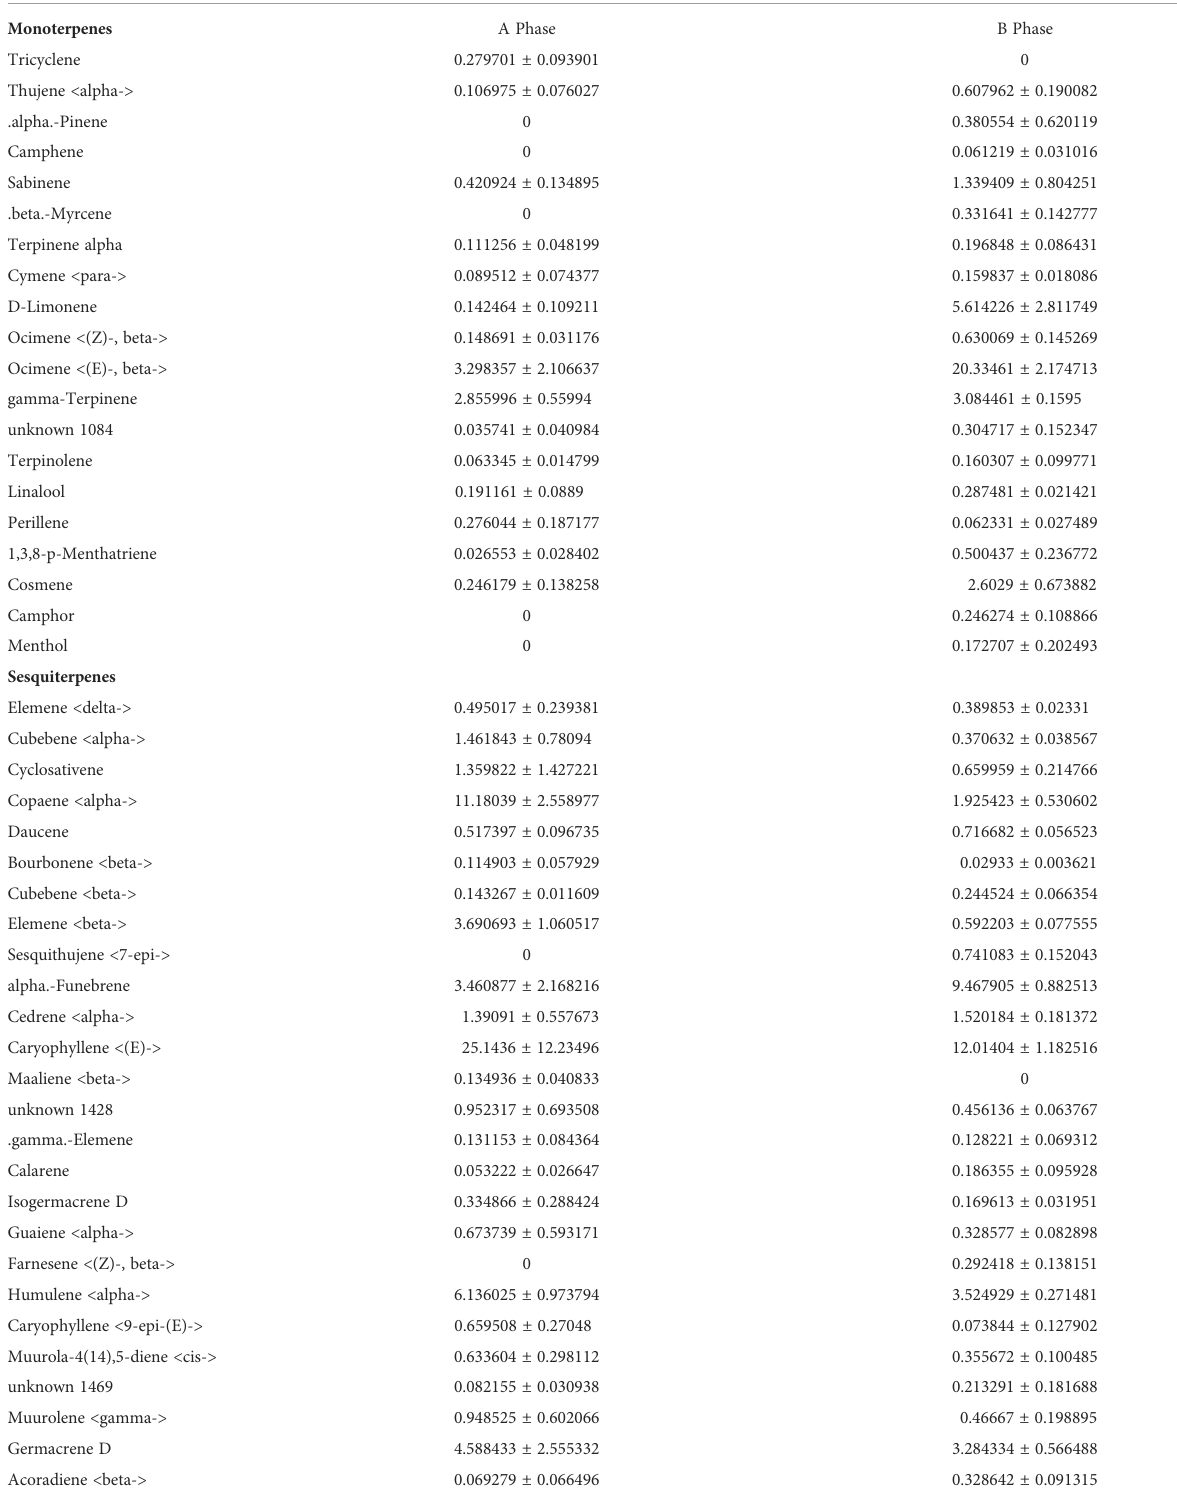
TABLE 1 Volatile compounds monoterpenes and sesquiterpenes emitted by F. hirta